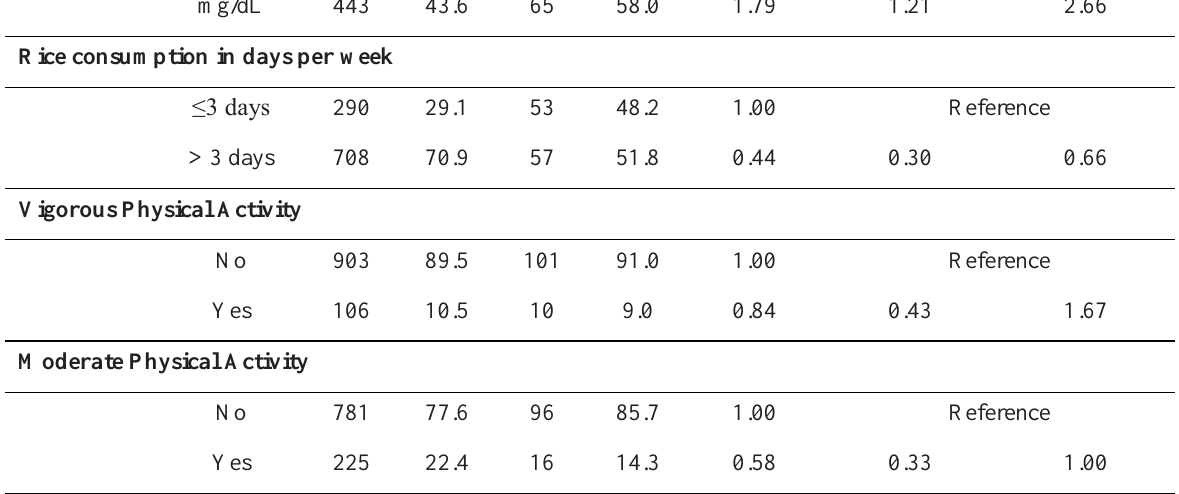
Table 1. Univariate analysis of demographic, socio-economic and behavioral factors associated with diabetes among study participants in Herat, Afghanistan